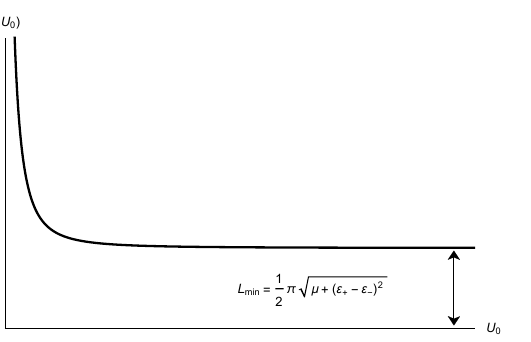
Figure 3 . L ( U 0 ) vs. U 0 for the case c 1 = 0 . Since µ is the only scale in the theory, one can express √ ε ± in terms of µ . To generate this numerical plot we have used ε + = 0 . 35